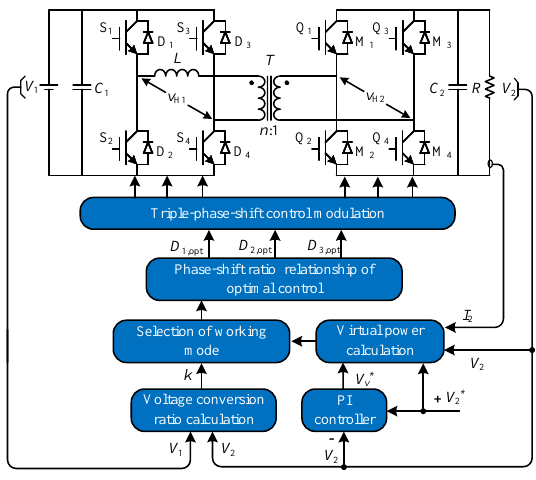
Figure 4. The MUOC